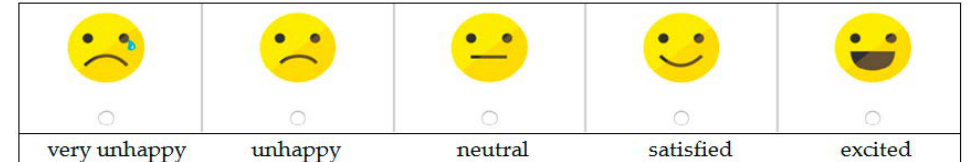
Figure 13. Emoticon-based Likert Scale used to collect young deaf user experience results.